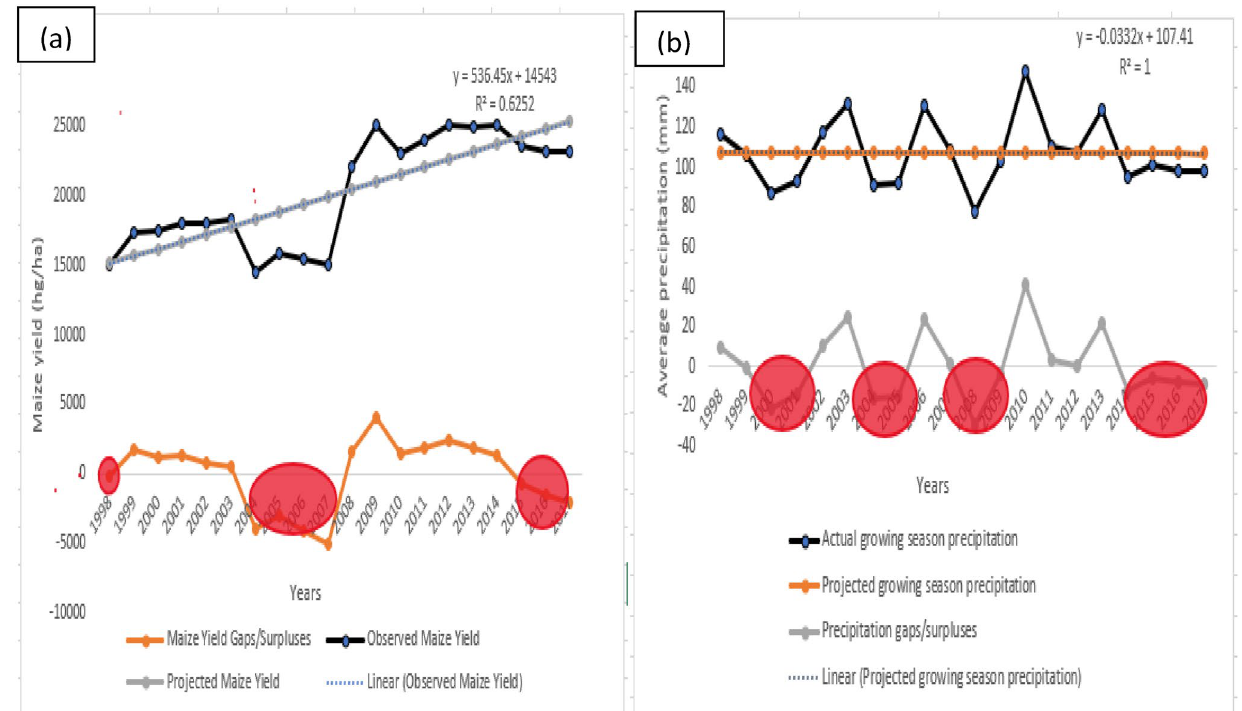
Fig.4 a Time series of projected, actual and yield gaps b time series of projected, actual and precipitation gaps in